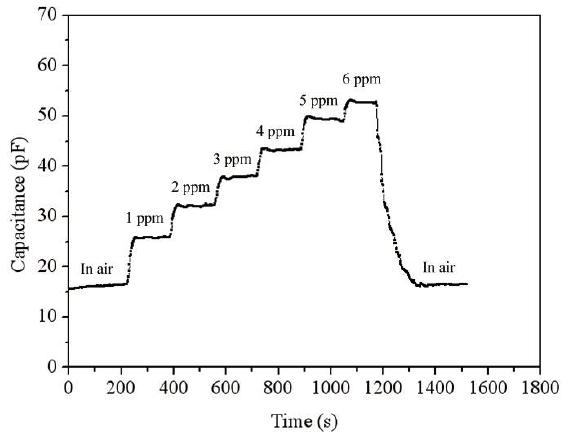
Figure 13. Reaction of the acetone sensor at 0–6 ppm acetone.